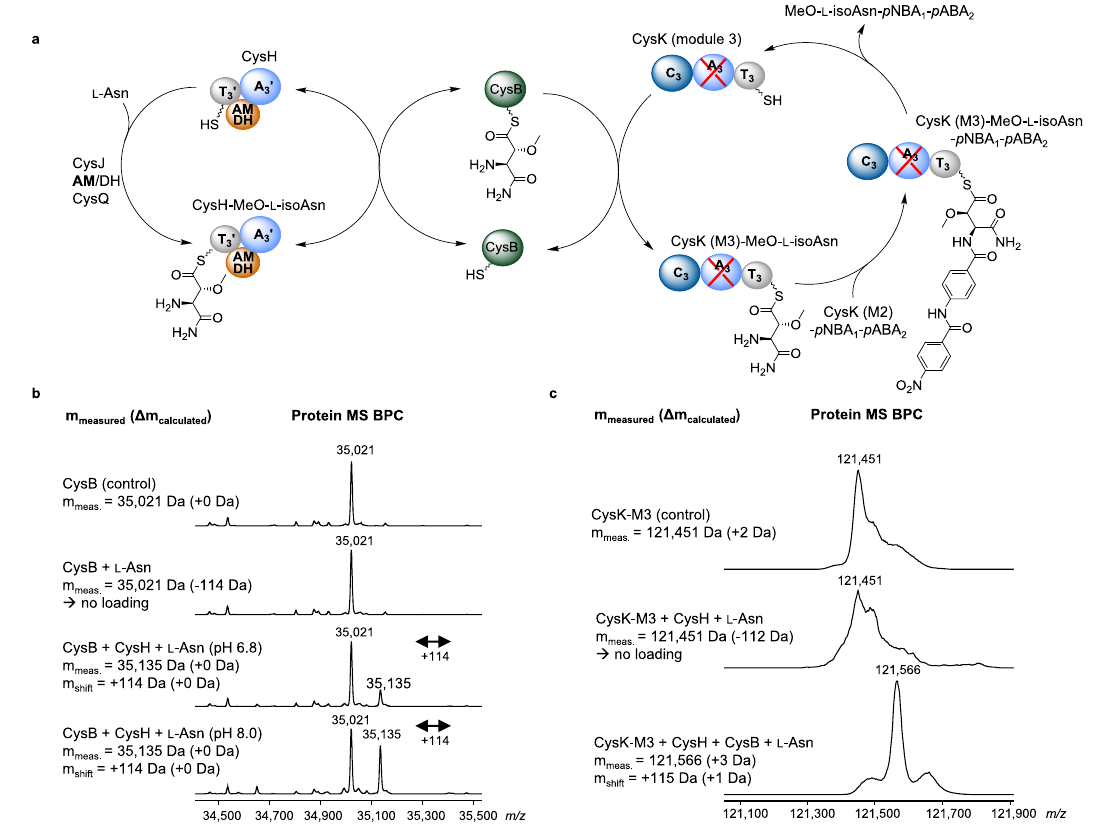
Fig. 6 CysB-mediated transfer of β -methoxy- L -isoasparagine from CysH to CysK. a Model for the CysB-mediated shuttling process. L -asparagine is activated by CysH and modi fi ed by CysJ, the AMDH domain, and CysQ as shown in Fig. 5. β -methoxy- L -isoasparagine is transferred from CysH to module 3 of CysK (M3) by CysB (green sphere). Condensation of the linker moiety with the p NBA 1 - p ABA 2 dipeptide leads to the formation of the shown tripeptide. b Deconvoluted protein MS analysis of CysB control; CysB incubated with free L -asparagine does not result in CysB loading; CysB incubated with L - asparagine and CysH leads to pH-sensitive loading of CysB ( + 114 m/z shift). c Protein MS analysis veri fi es the transfer of L -asparagine from CysB to CysK (M3) in the presence of CysH. Blue sphere: adenylation domain; gray sphere: thiolation domain; orange sphere: AMDH domain; red cross: inactive